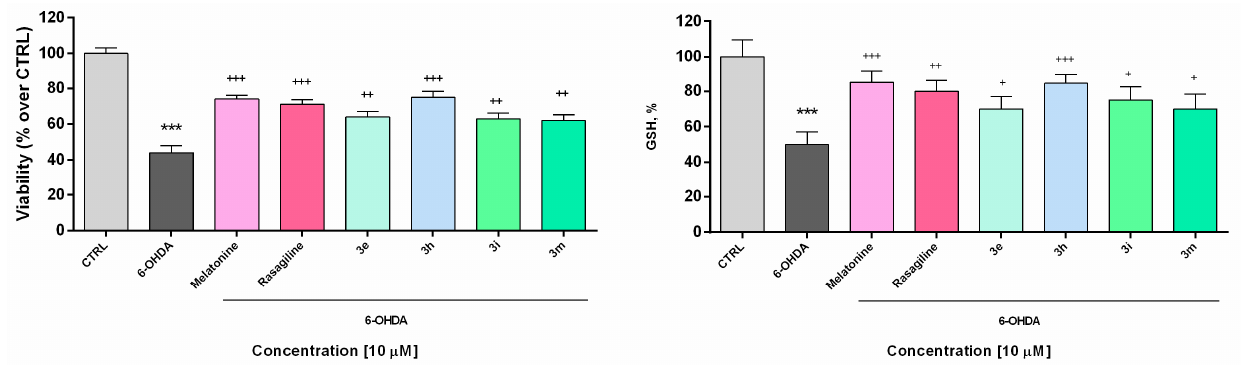
Figure 3. Effect of the tested benzimidazole aryhydrazones 3e , 3h , 3i , 3m (10 µ M) on the synaptosomal viability and GSH levels in a model of 6-OHDA (150 µ M) induced oxidative stress compared to the reference compounds rasagiline and melatonin. Data are represented as means from three independent experiments ± SD. *** p < 0.001, vs. untreated control (CTRL); + p < 0.05, ++ p < 0.01, +++ p < 0.001 vs. 6-OHDA (one-way analysis of variance with Dunnet’s post hoc test).